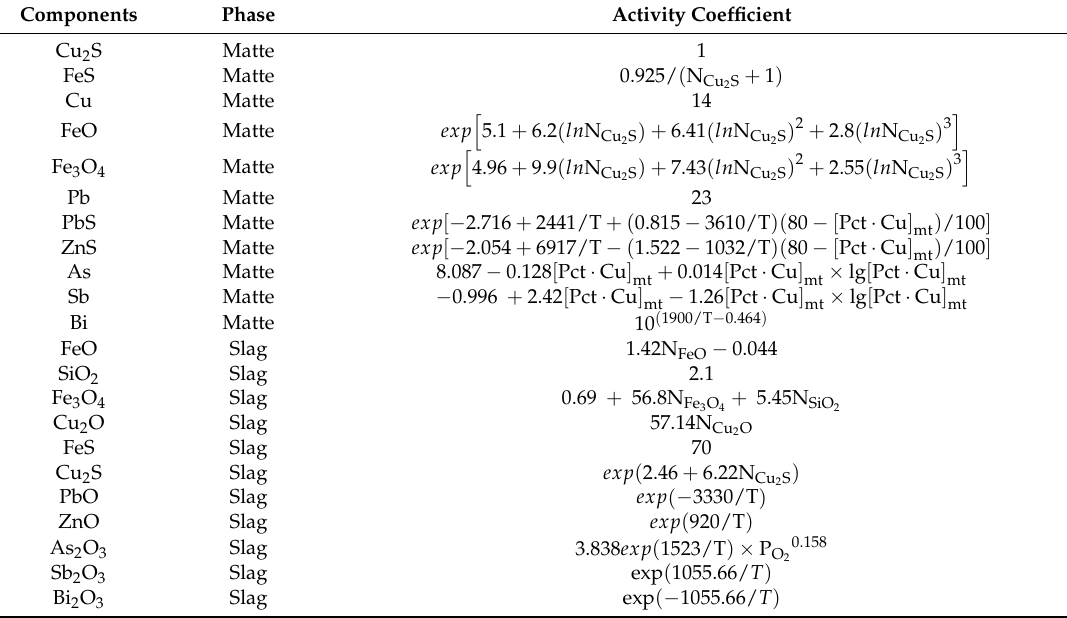
Table 2. Activity coefficient in the SKS process.